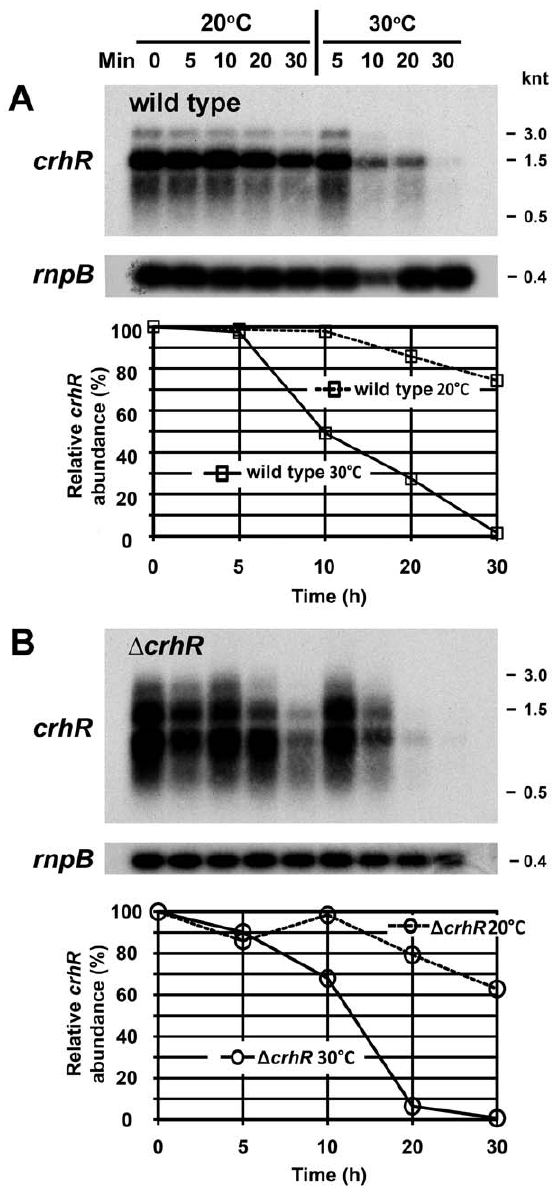
Figure 4. crhR transcript half-life. Wild type ( A ) and D crhR ( B ) Synechocystis were grown at 30 u C to mid-log phase (0 min) at which time the cultures were cold stressed at 20 u C for 1 h to induce maximal crhR transcript abundance. de novo RNA synthesis was subsequently inhibited by the addition of rifampicin (400 m g/ml) and one-half of the culture transferred back to 30 u C. Aliquots for RNA extraction were harvested at the indicated times. crhR transcript was detected in total RNA probed with a 93 bp Hinc II- Sac II internal fragment of crhR . The blots were stripped and probed with the Synechocystis rnpB gene as a control for RNA loading. Quantification of relative transcript abundance (%) at each time point is provided below each lane, normalized for the level of rnpB detected in each lane as described in Methods S1. Open circles, D crhR ; open boxes, wild type. RNA manipulation RNA was extracted using glass bead lysis in the presence of phenol followed by extensive phenol-chloroform extraction and lithium chloride precipitation. Northern analysis, using a 32 P-